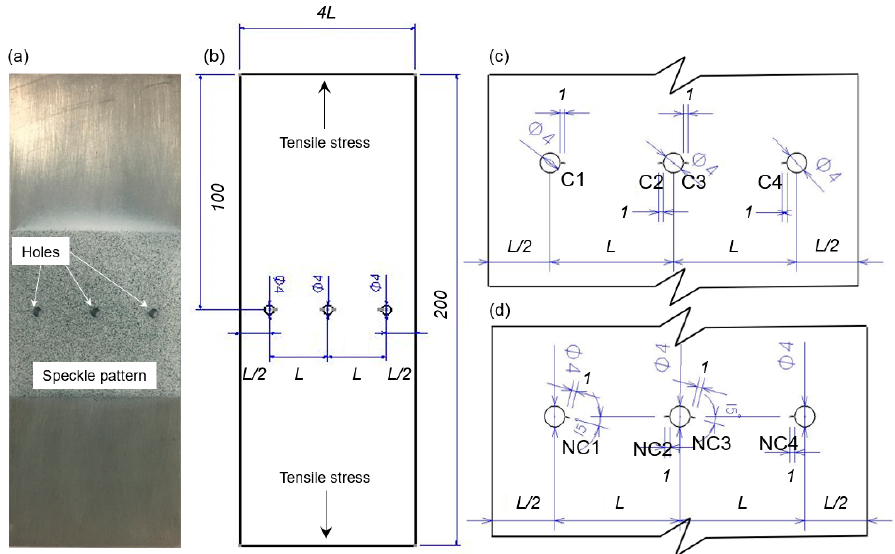
Figure 1. The geometry and dimension of the hollow pre-notched specimen (mm): ( a ) the specimen with speckle pattern, ( b ) the dimensions of the specimen, ( c ) the partial dimensions of the collinear cracked specimens (CC), and ( d ) the partial dimensions of the non-collinear cracked specimens (NCC). C1-C4 represent the four cracks in the collinear cracked specimens while NC1-NC4 represent those in the non-collinear cracked specimens.